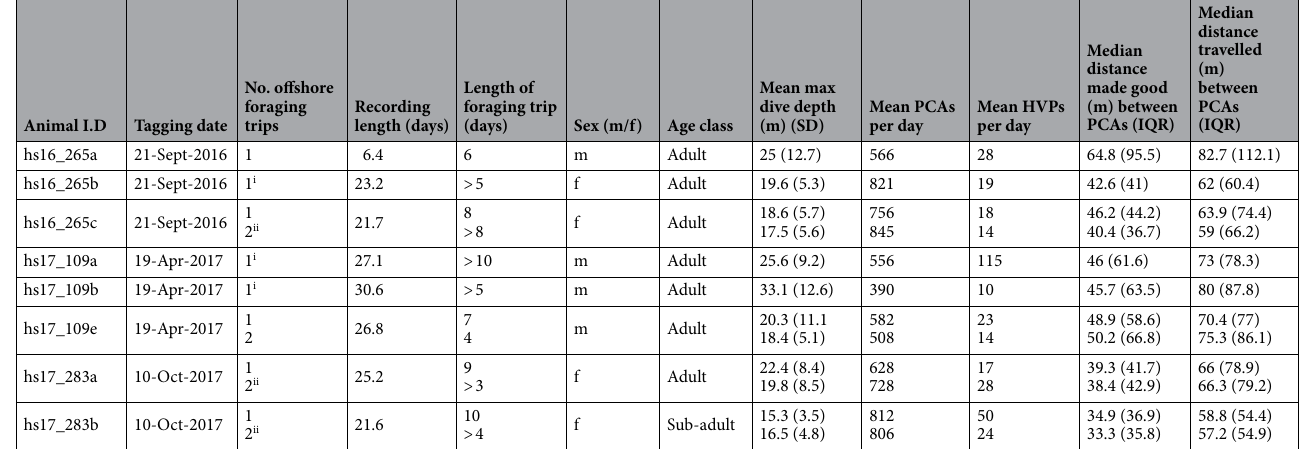
Table 1. Summary of tagged individuals performing multi-day foraging trips. PCAs are presumed prey capture attempts inferred from acceleration transients. HVPs are ‘high value prey’ captures in which prey appear to be brought to the surface for handling. Distance made good is the straight-line distance between successive PCAs. Distance travelled is the total distance travelled by the animal between successive PCAs. i First foraging trip incomplete, ii second foraging trip incomplete.